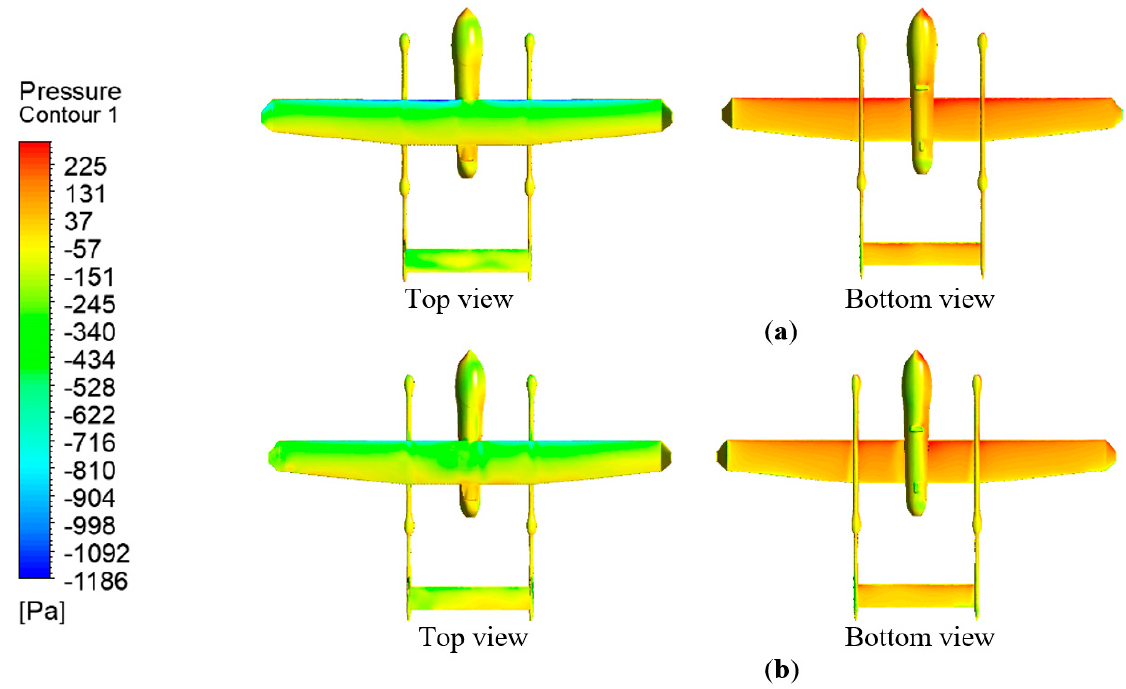
Figure 14. Pressure contour on 15 ◦ AoA, sideslip angle: ( a ) 15 ◦ and ( b ) 30 ◦ . The C P value was analyzed to find the longitudinal stability of the aircraft. The moment aerodynamics value on the CoG was used to find out the C P value using Equation (25). Figure 15 shows a graph of the coefficient of moment vs. AoA during crosswind.